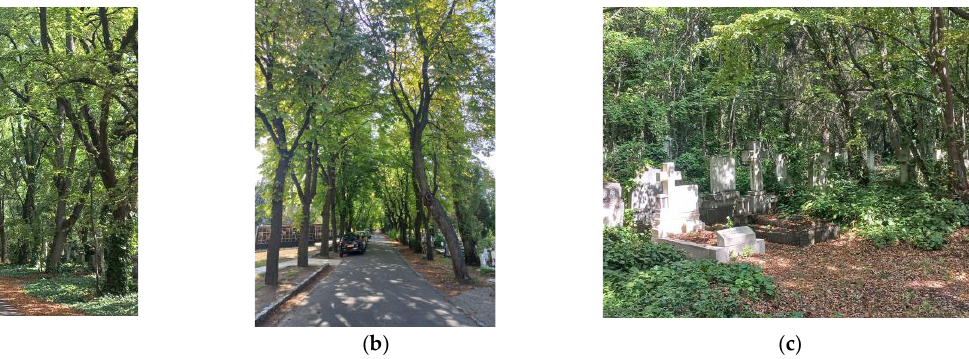
Figure 4. Új Köztemető, Budapest: ( a ) lime tree alley along one of the main roads in the cemetery, Figure 4. Ú j Köztemet˝o, Budapest: ( a ) lime tree alley along one of the main roads in the cemetery, ( b ) chestnut tree alley, ( c ) wooded plot (authors ’ photos, 2022). ( b ) chestnut tree alley, ( c ) wooded plot (authors’ photos,